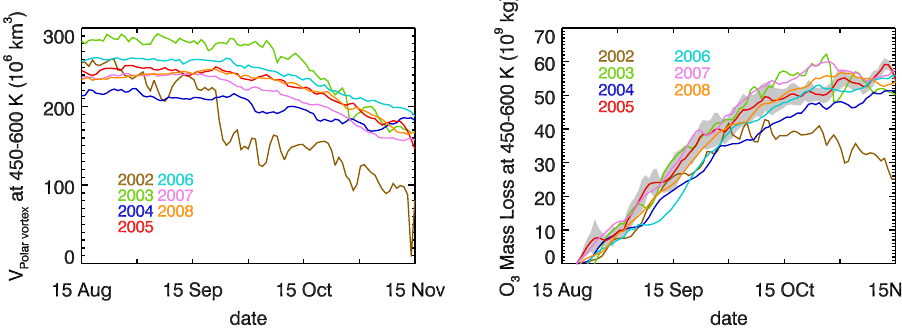
Fig. 12. Time evolution of the polar vortex volume (left panel) and the ozone mass loss inside the vortex (right panel) between the 450K and 600K isentropic levels in the Antarctic winter stratosphere. The ozone losses below the 550K level are driven by halogen compounds formed in heterogeneous reactions, while at higher isentropic levels NO x driven ozone losses may become important near the end of austral spring.